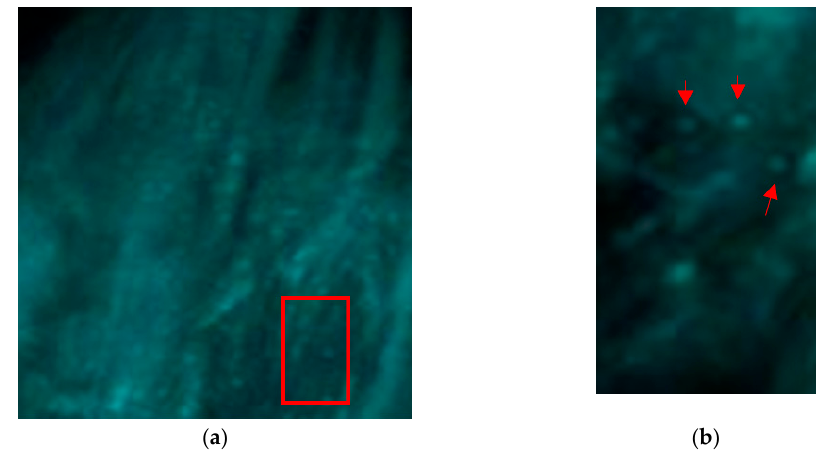
Figure 4. Shows a 3D view of the mouse calf, in ( a ), 3D visualization of the mouse calf, the rectan- gular shape is zoomed and presented in ( b ). Red arrows pointing to the blue ball-shaped particles representing clusters of